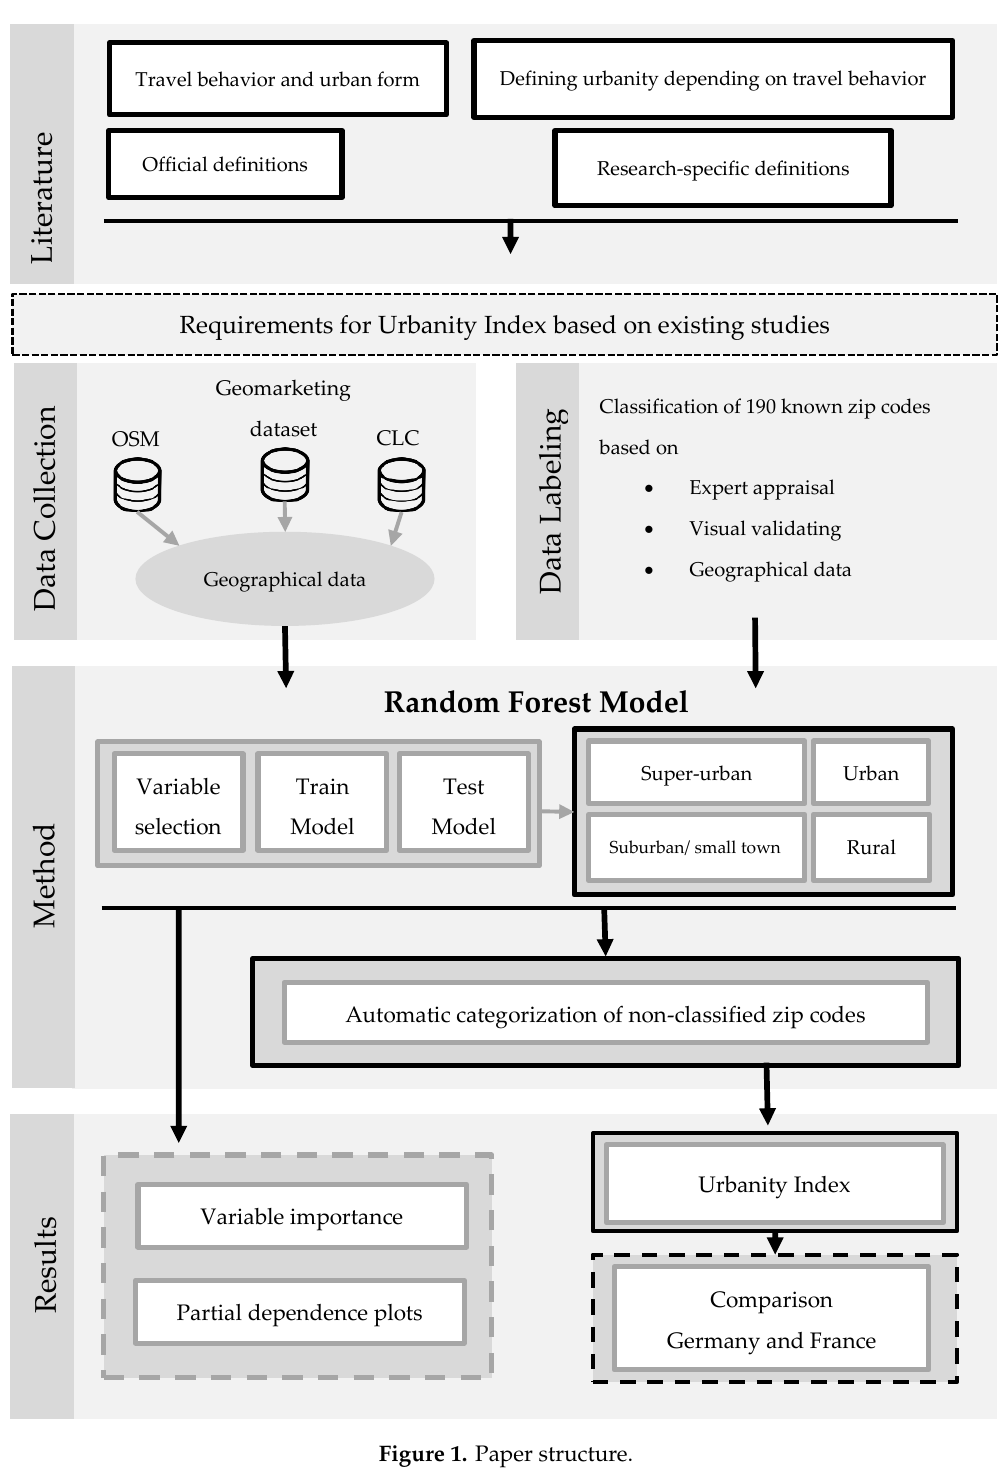
Figure 2. Paper structure Figure 1. Paper structure Figure 1. Paper